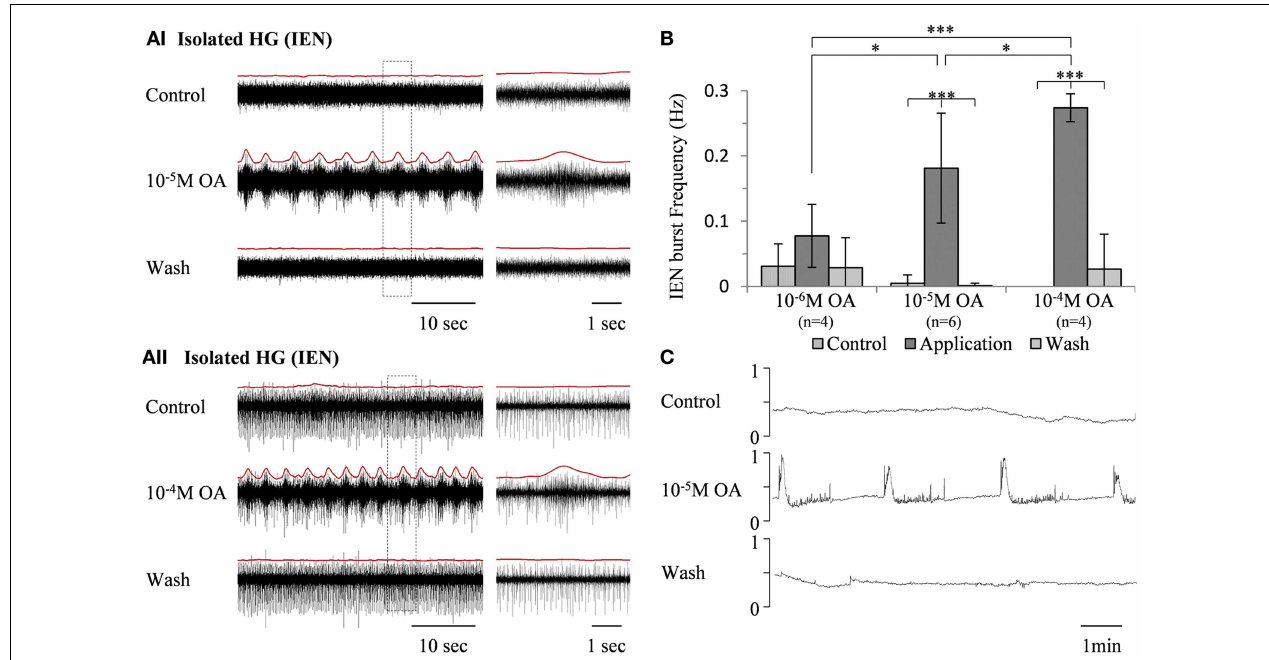
the dose-dependent excitatory effect.Values are means ± S.D. (C) Output of a force transducer connected to the crop wall showing the effect of 10 − 5 M octopamine on an in vitro foregut preparation that included the HG, with intact IEN foregut innervation. y -Axes are normalized units of the force transducer voltage